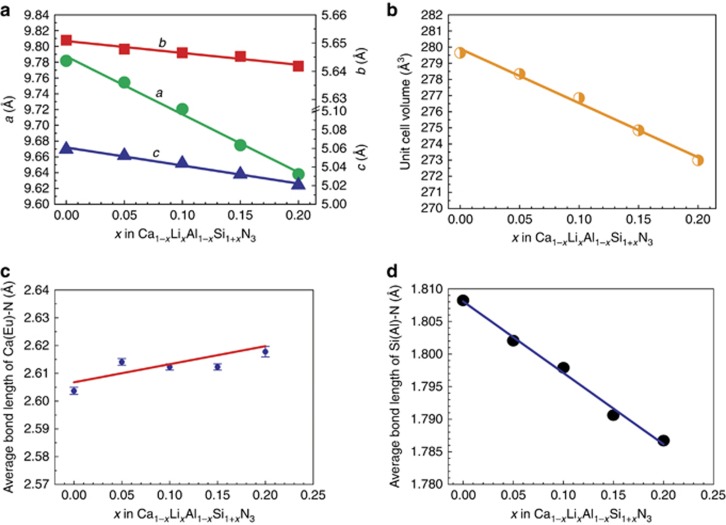
Effect of solubility of LiSi2N3 (x value) on (a) lattice constants, (b) cell volume, (c) the Ca(Eu)–N distance and (d) the (Si,Al)–N distance of CaAlSiN3:Eu2+.